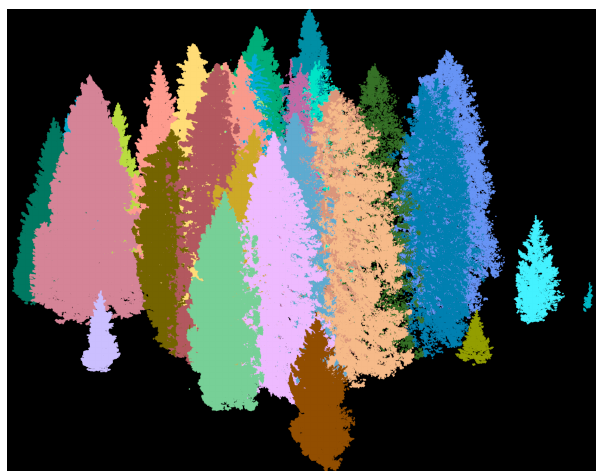
Figure B2. As an example, segmentation results for one of the las tiles at site